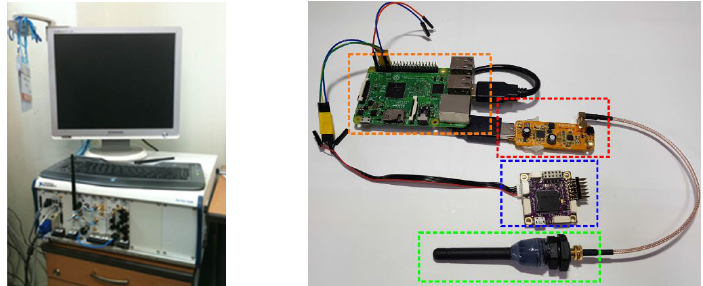
Figure 8. Hardware setups for EM-based localisation; using an external vector spectrum analyzer [105,106] ( left ) and the miniaturized DVB-T USB-dongle SDR-based concept with single board computer by [109,110] ( right